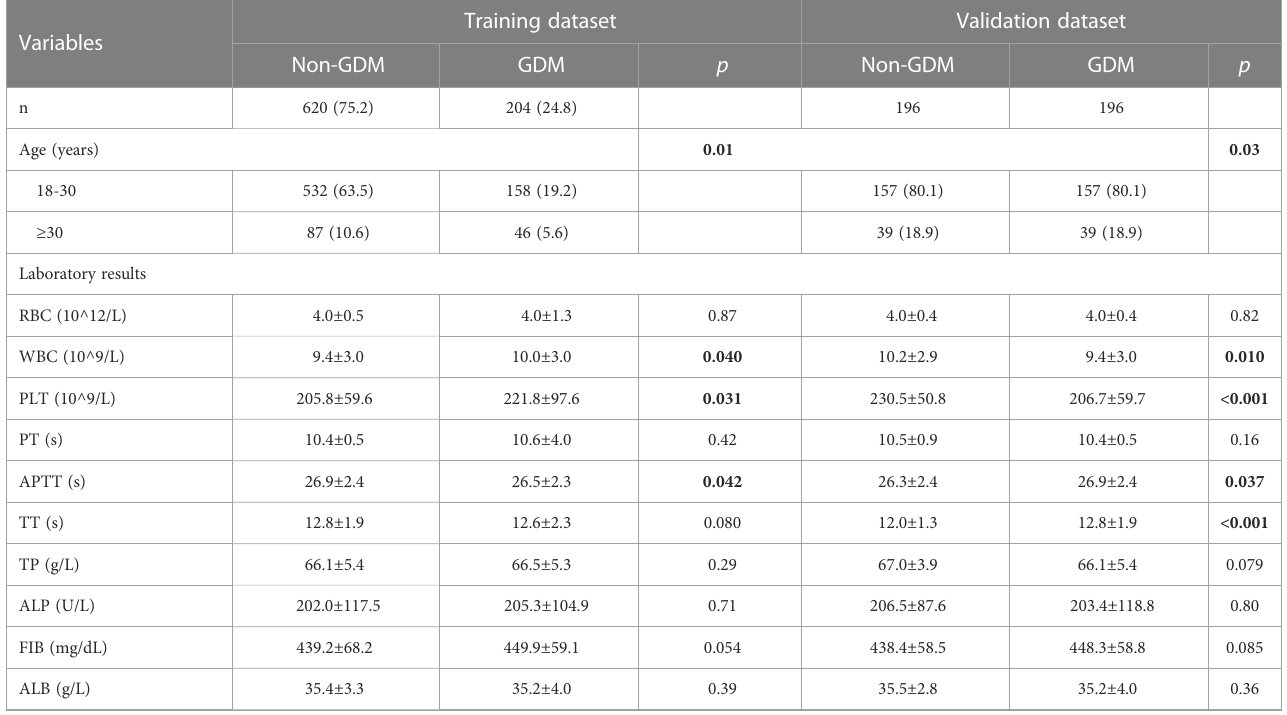
TABLE 2 The baseline characteristics of